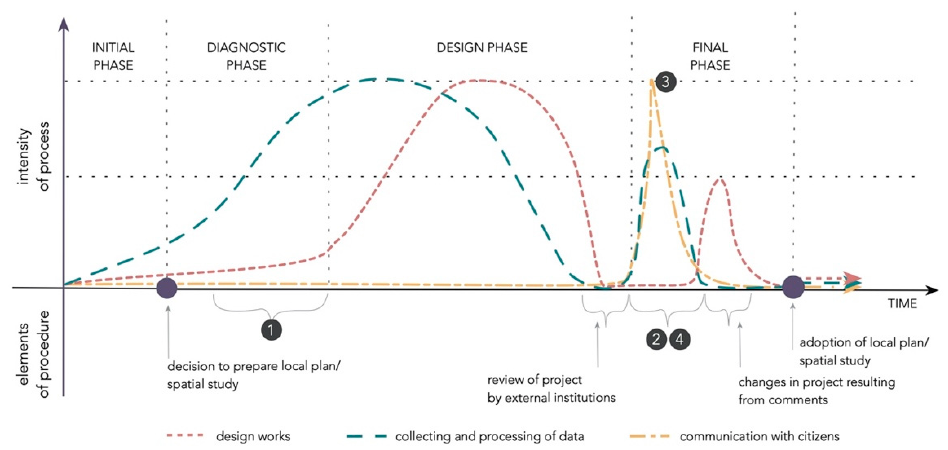
Figure 1. Model of formal spatial planning in Poland. Source: own elaboration based on act on spatial planning and development of March 2003.